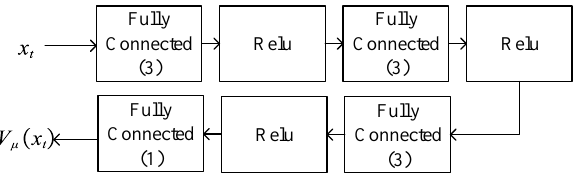
Figure 5. Critic Net.